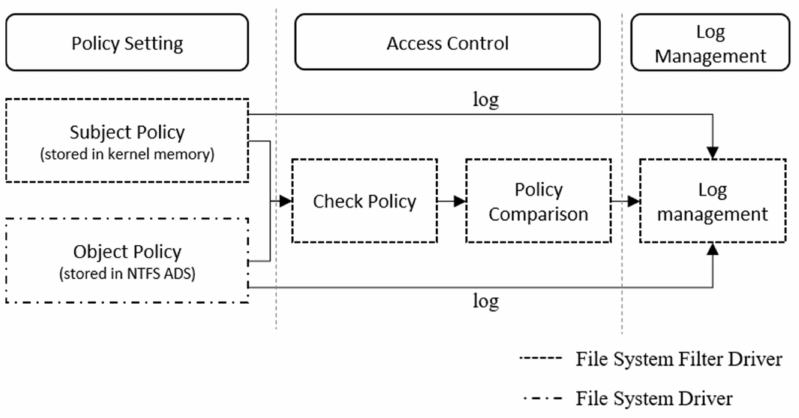
Figure 6. Design and implementation of the MAC-based file system filter